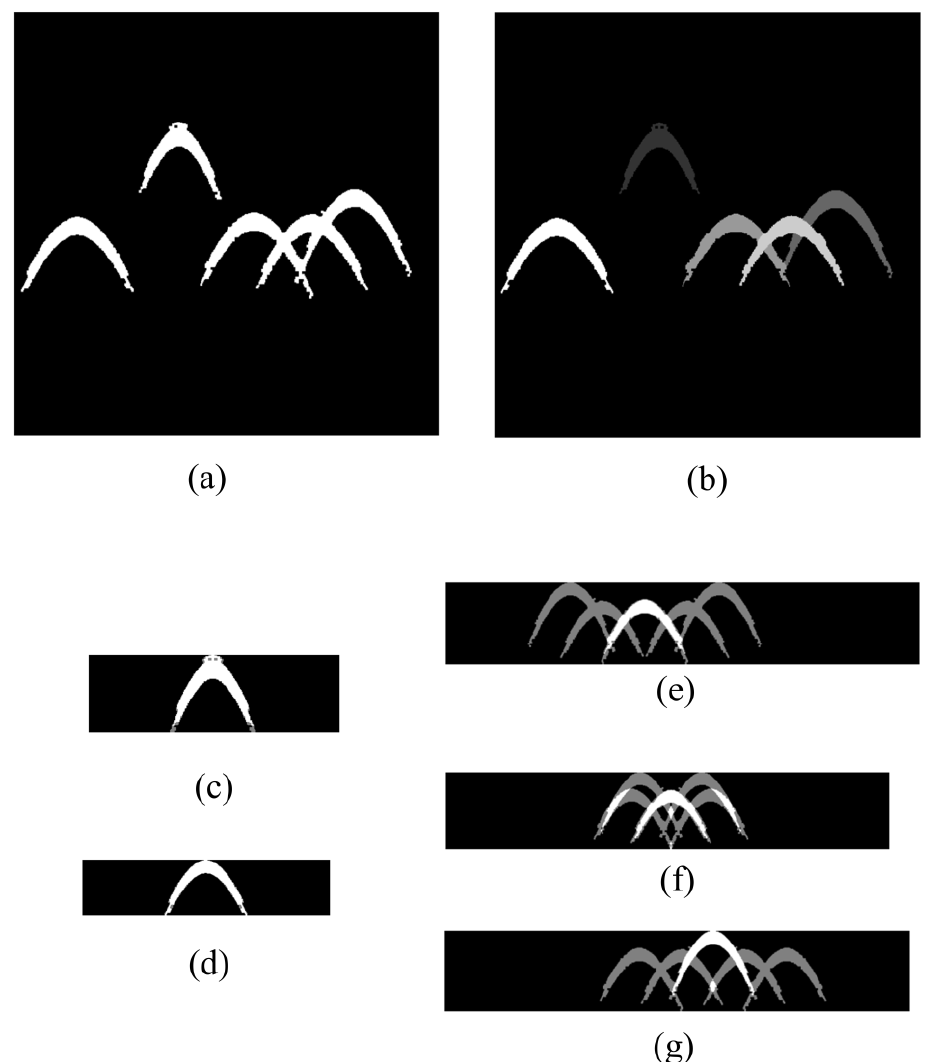
Figure 8. Separate overlapping hyperbolas with symmetry test for simulation image. ( a ) The original image before segmentation. ( b ) The result after separation. ( c – g ) The intermediate results of the symmetry test for the hyperbolas in ( a ) from left to right.